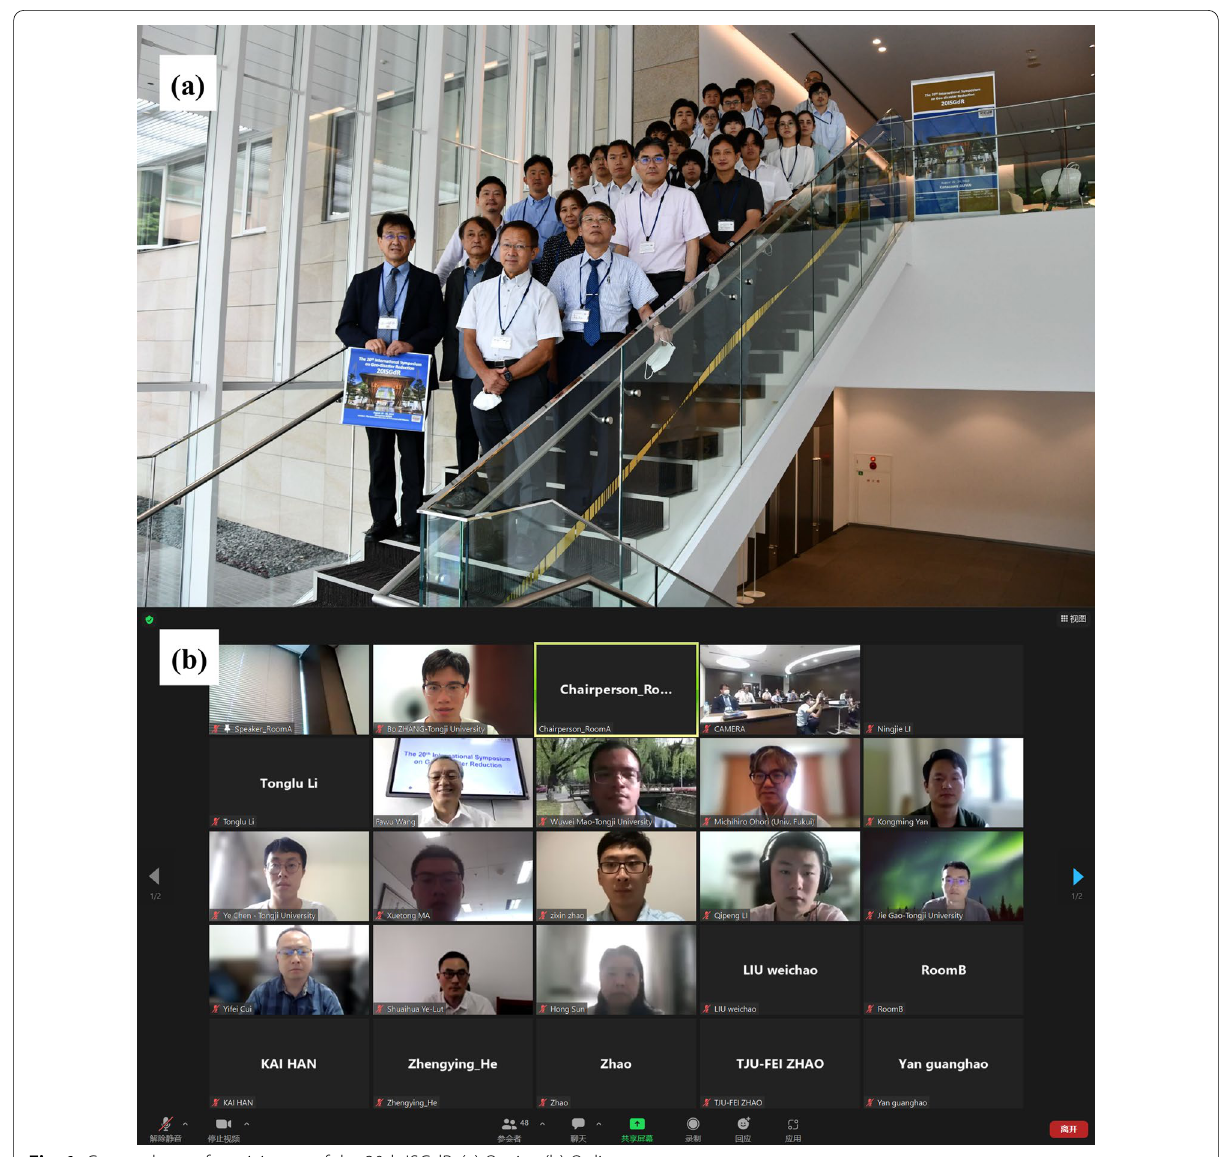
Fig. 1 Group photo of participants of the 20th ISGdR: (a) Onsite; (b)